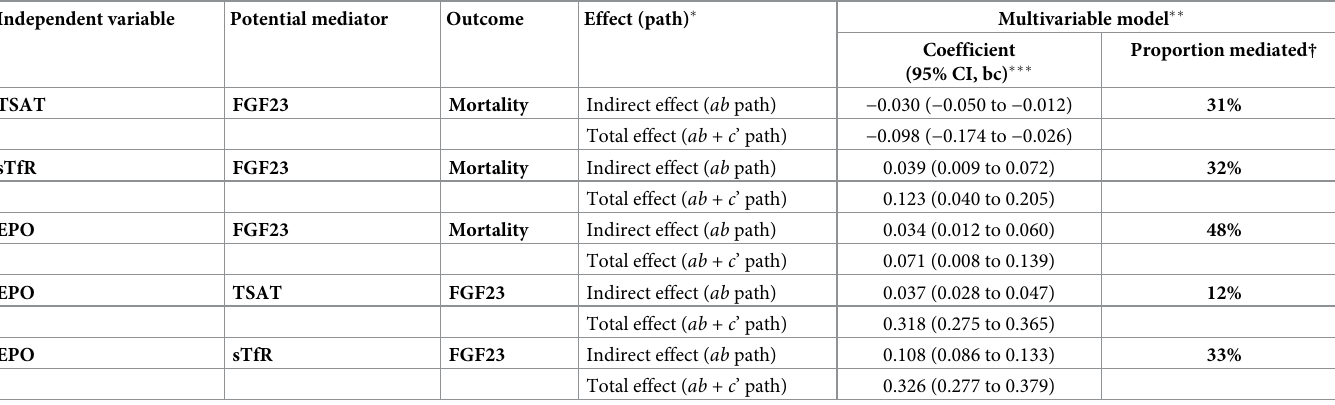
Table 3. Mediation analyses of FGF23 on the association between TSAT, sTfR, EPO, and mortality in the general